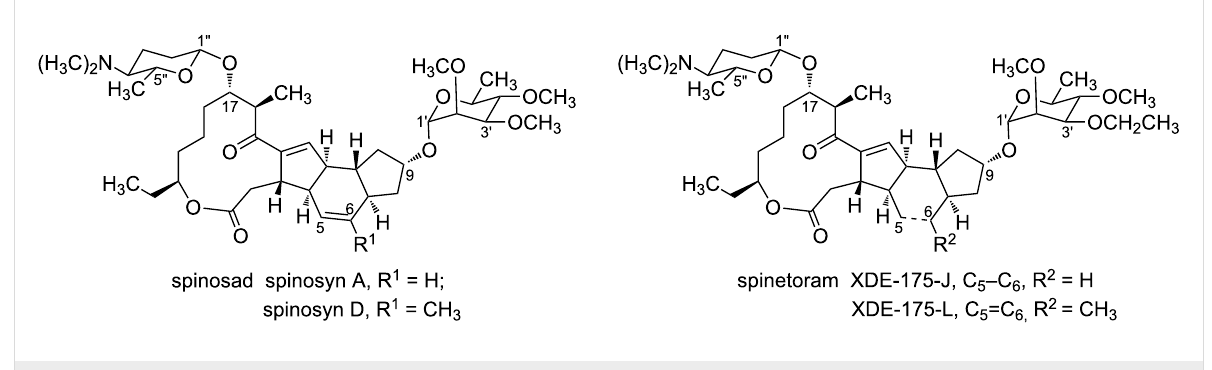
Figure 1: The structures of spinosad and spinetoram.